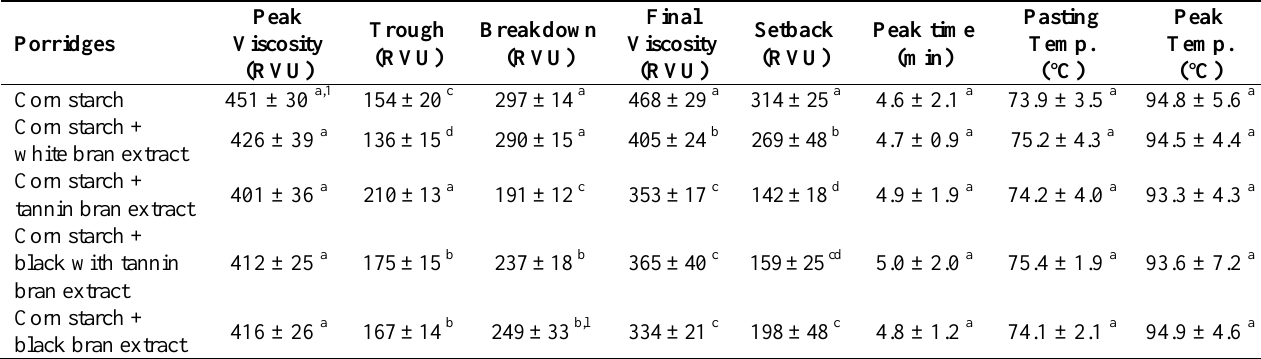
Table 2. Pasting properties of corn starch porridges cooked with sorghum bran extracts by Rapid Visco Analyzer.